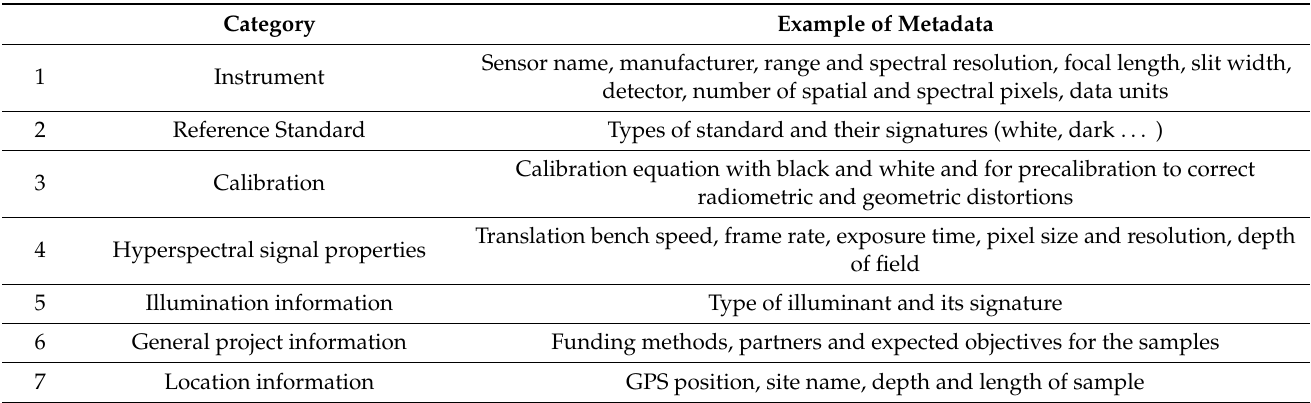
Table 5. Example of metadata that can be utilized to present the raw data. (Categories proposed by [197].). Category Example of Metadata